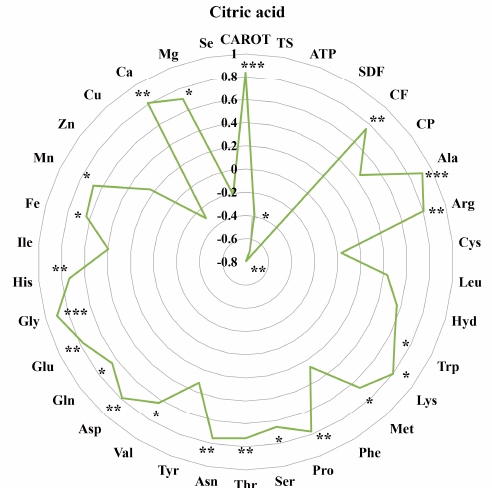
Figure 4. Correlation analysis between citric acid and the main nutrients and mineral elements. * p < 0.05; ** p < 0.01; *** p < 0.001.